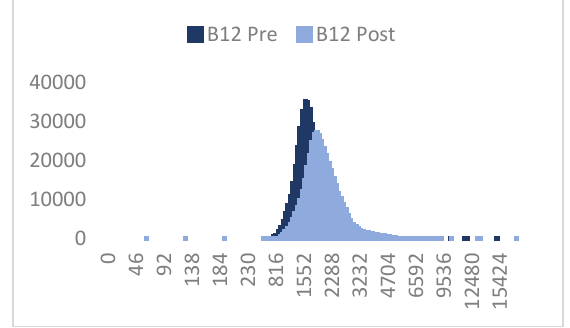
Figure 2 Sentinel-2 pseudo-color imagery (B12, B11 and B8) before the fire event 2/7/2021